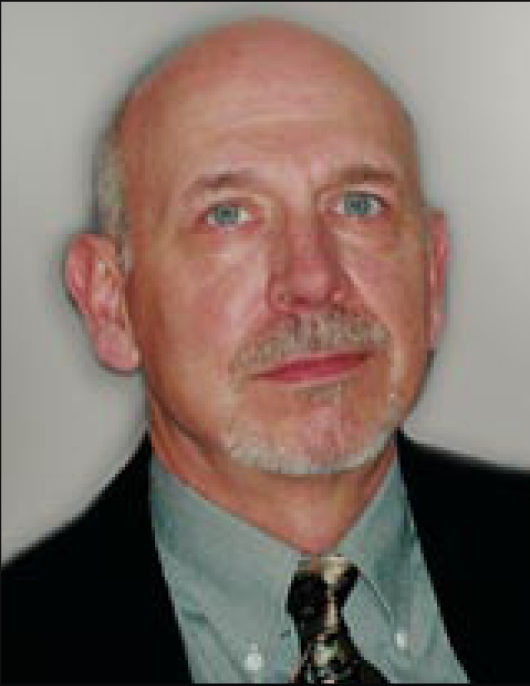
Stephen M. Rappaport